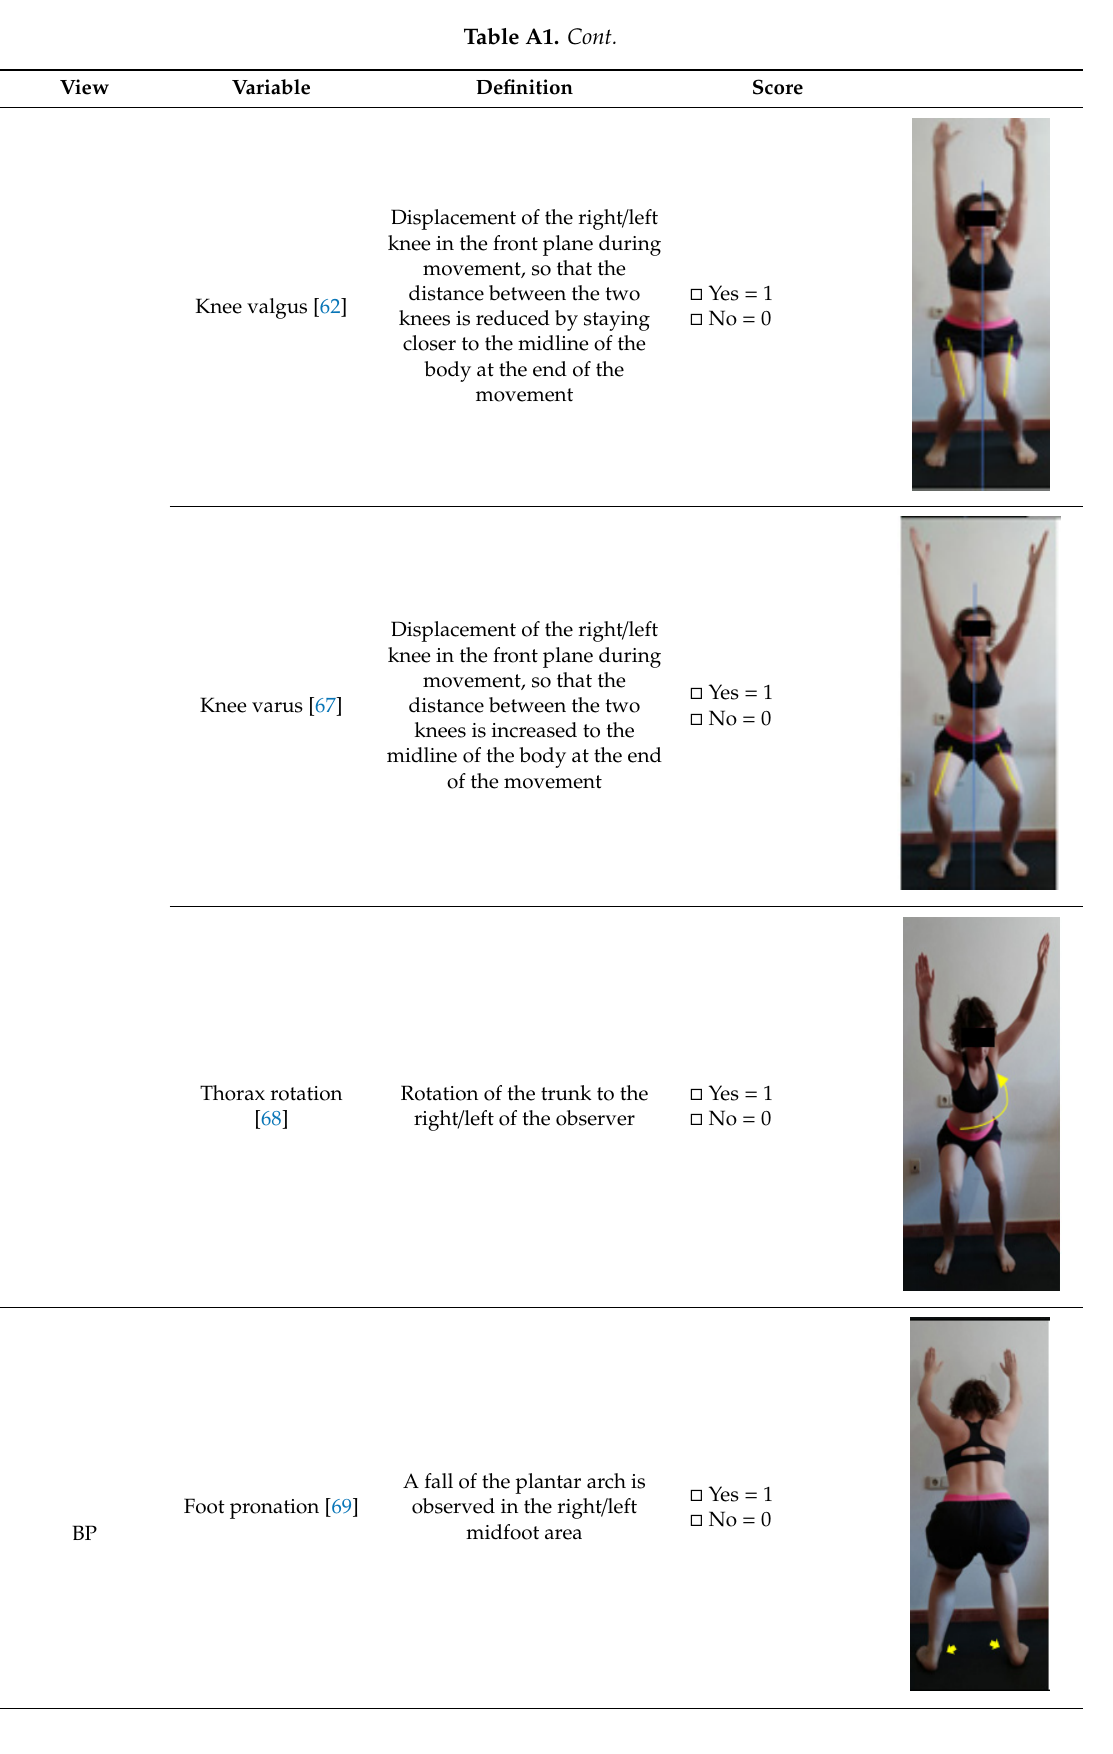
Table A1. Summary of variables with definition and graphic image .